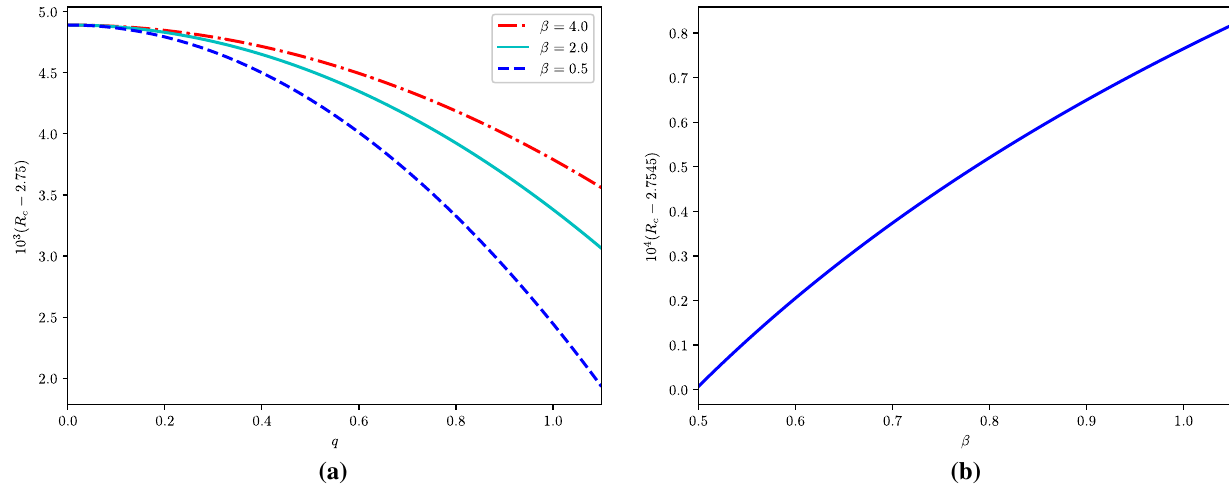
Fig. 3 a The profile functions A 0 and χ of a solution for the Gaussian charge distribution; β = 2 . 0, q = 0 . 4, R s = 0 . 1 / distributions of the same solution. The dotted vertical line shows r = R s and the dashed one r = R c